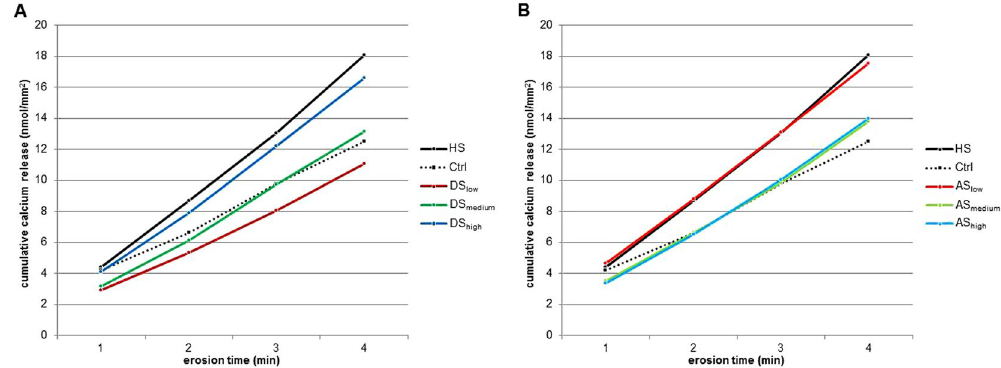
Figure 3. Mean cumulative calcium released during erosion cycles. (A) Calcium released for all DS groups compared to HS and Ctrl. A trend toward more calcium release from DS low to DS high was observed. (B) Calcium released for all AS groups compared to HS and Ctrl. A trend toward less calcium release from AS low to AS high was observed.